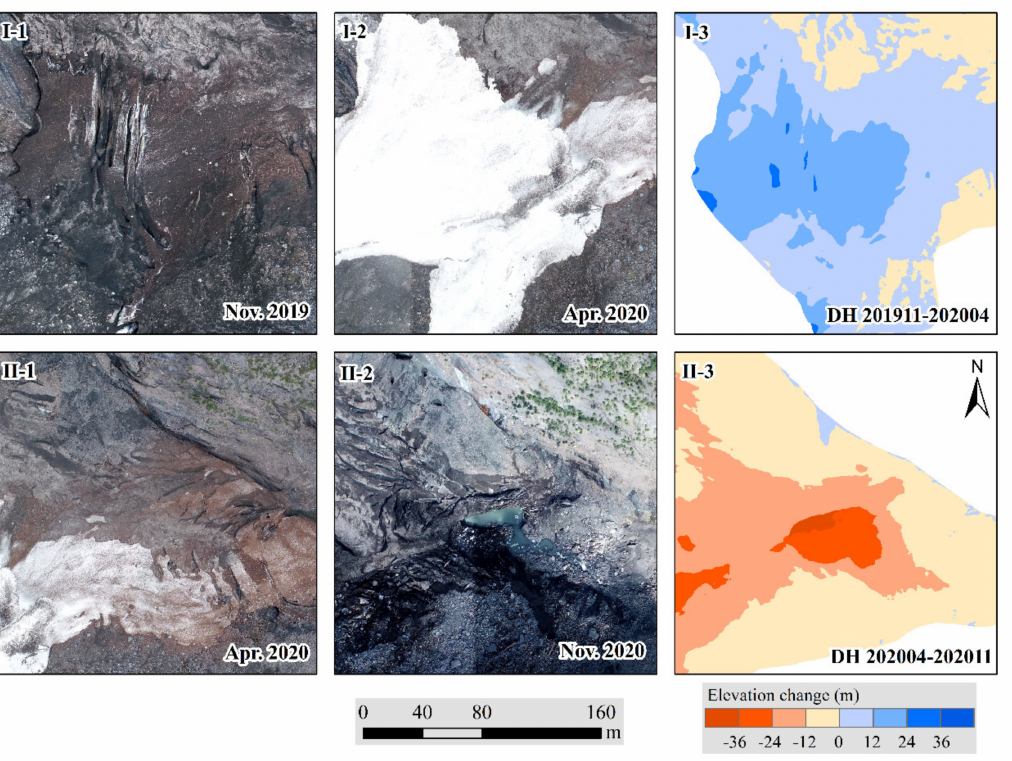
Figure 8. Changes in surface features around selected locations. ( I-1 – I-3 ) The orthophotos in